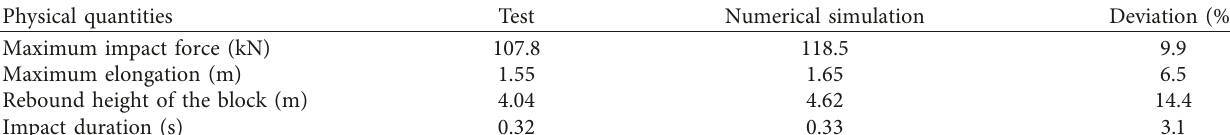
Table 3: Comparison of test results and the numerical simulation results.